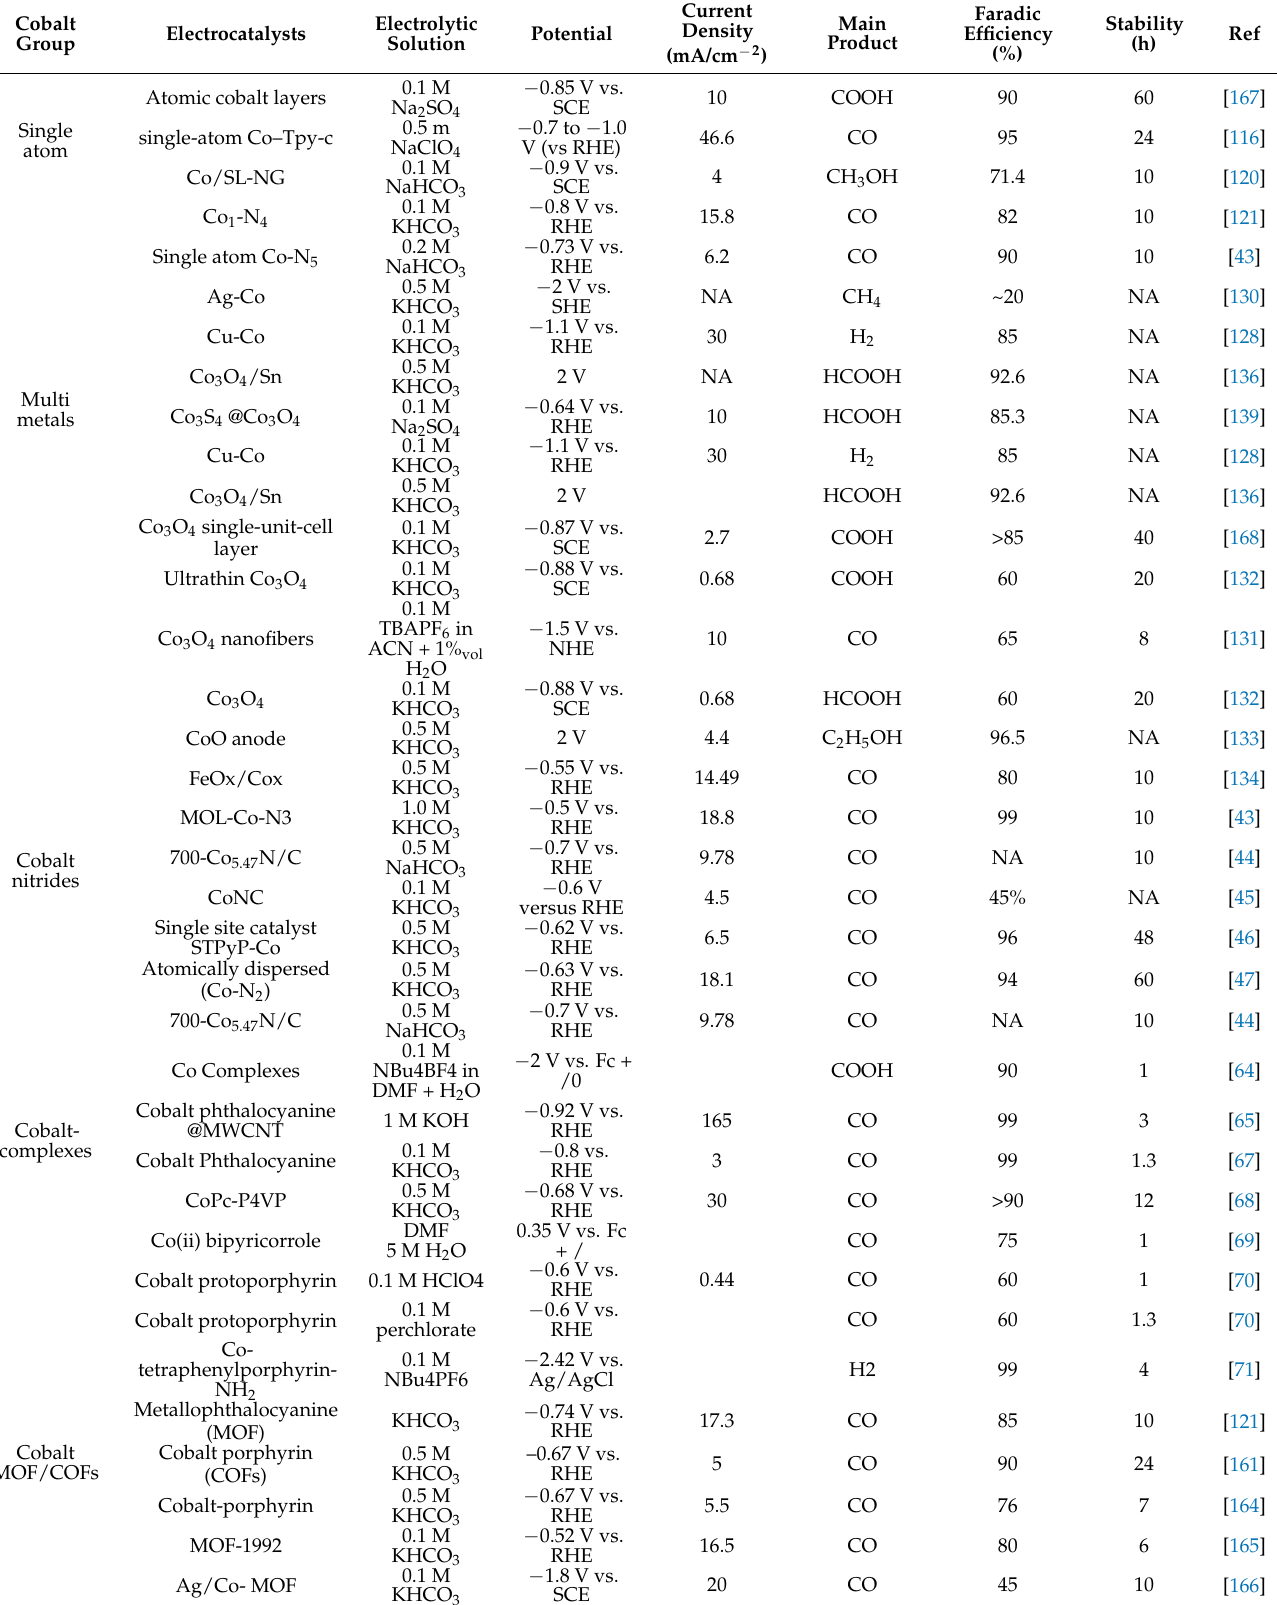
Table 1. Performance of cobalt-based electrocatalysts for Electrochemical CO 2 reduction. Cobalt